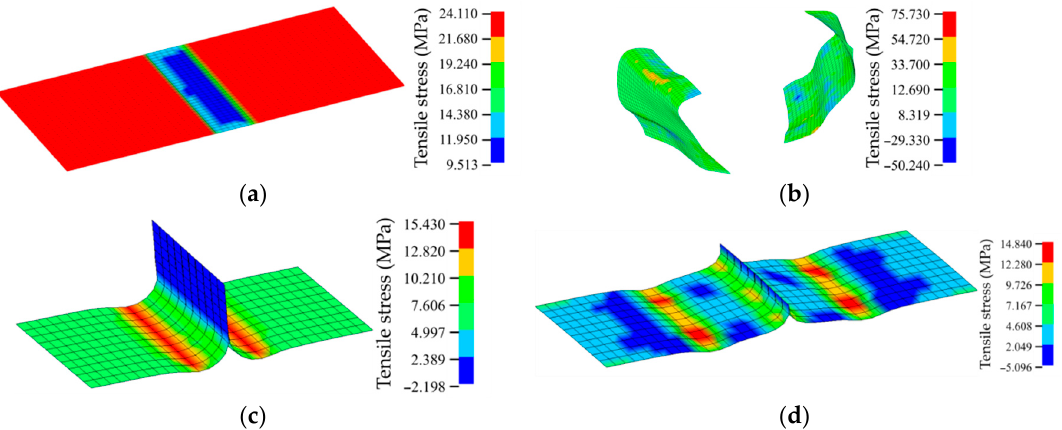
Figure 13. Visualization of failing welds for shear loading (intact (a); destroyed (b)) and peel loading (intact (c); destroyed